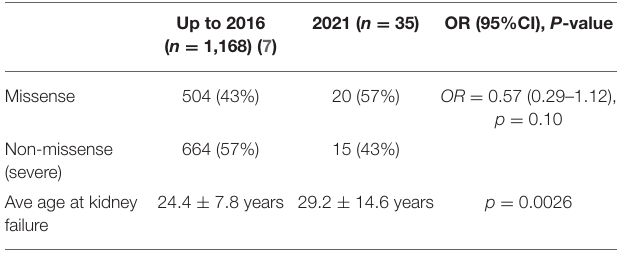
TABLE 4 | Average age at kidney failure in males with pathogenic COL4A5 variants in LOVD in 2021 compared with